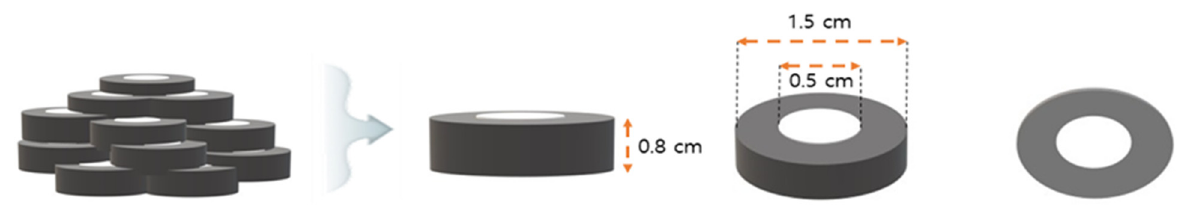
Figure 10. Structure of the manufactured pellet-type catalyst.